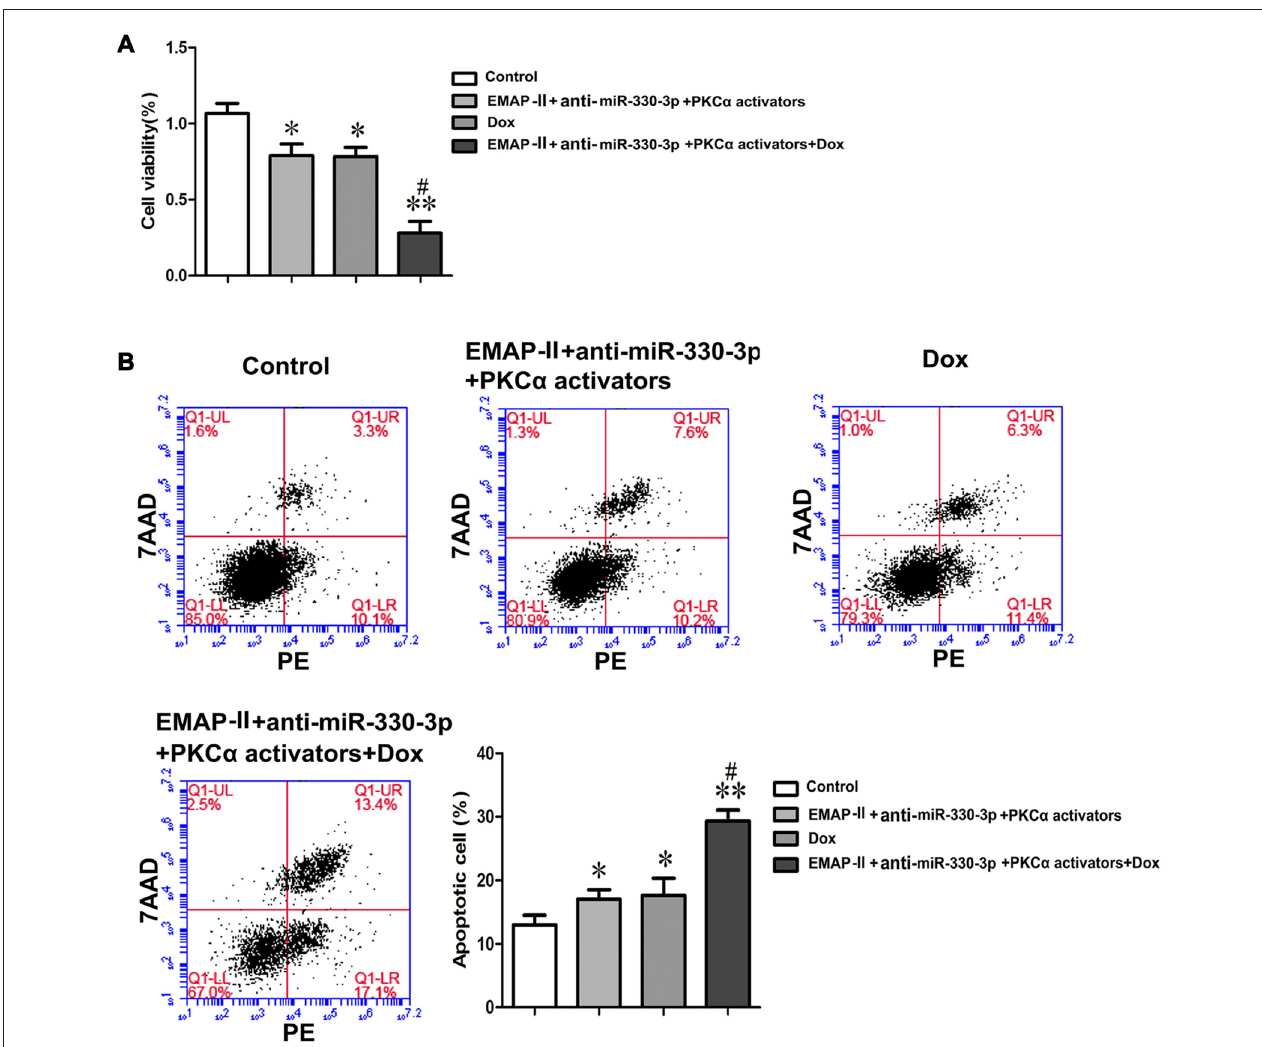
FIGURE 7 | EMAP-II combined with anti-miR-330-3p and PKC α activator enhance the effects of DOX on inhibiting the cell viabilities and promoting the apoptosis of U87 glioma cells. (A) The cell viabilities of U87 glioma cells were assessed by MTT. (B) Apoptosis analysis inU87 glioma cells was evaluated by Annexin V-PE/7-AAD staining. Values are means ± SD ( n = 5, each). ∗ P < 0.05, ∗∗ P < 0.01 vs. control group; # P < 0.05 vs. DOX